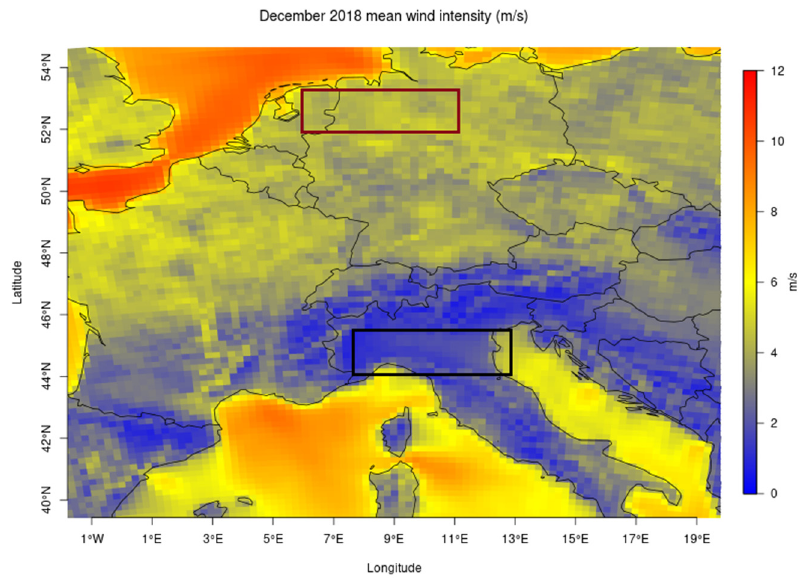
Figure 14. December 2018 average wind speed. The two areas (boxes) selected for the experiment are the Po Valley flat area and Northern–Central Europe area.